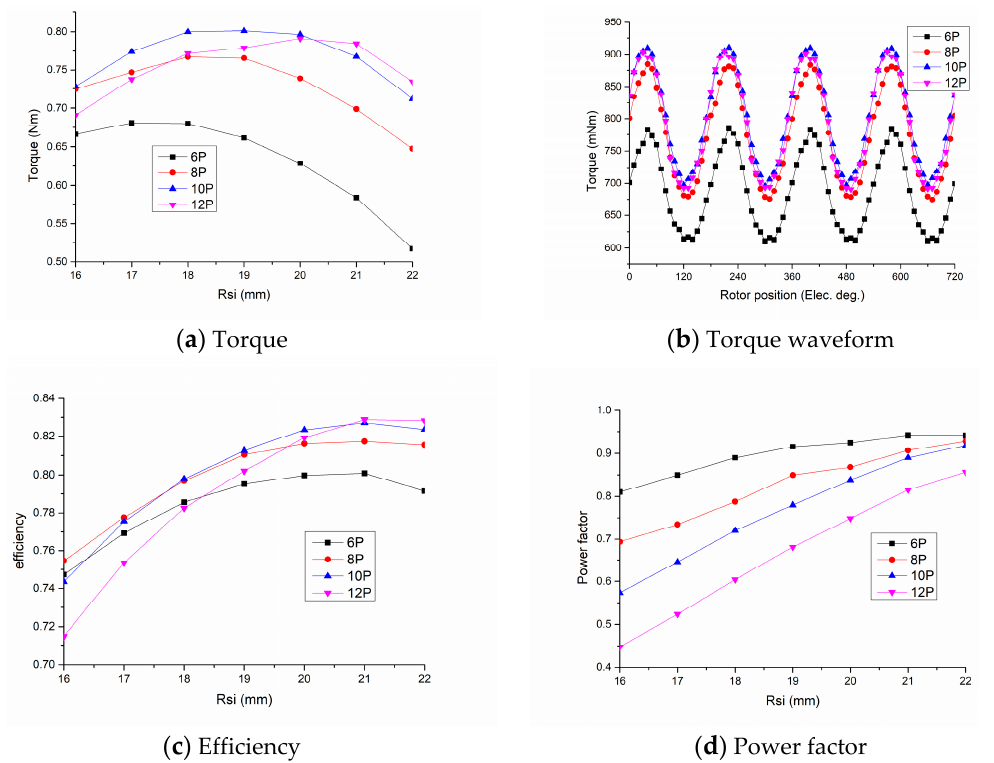
Figure 8. Overall performance comparison of the CPM with different numbers of pole pairs and different design parameters.